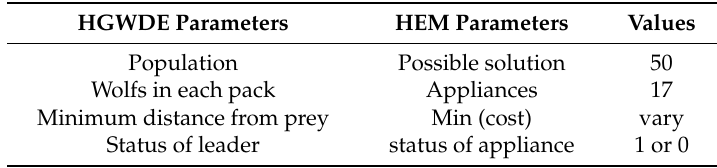
Table 6. Hybrid gray wolf differential evolution (HGWDE) mapping on